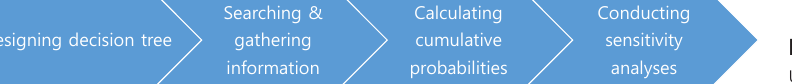
Figure 1. Steps of clinical decision analysis using decision tree